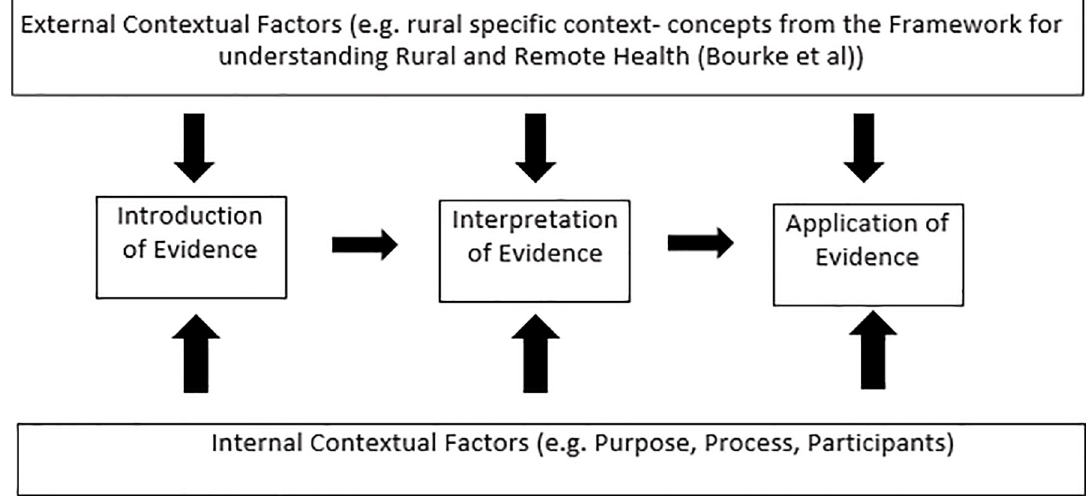
Fig 1. Applying the conceptual framework for understanding rural and remote health (Bourke et al., 2012) to the framework for context-based evidence-based decision making (Dobrow et al., 2004).